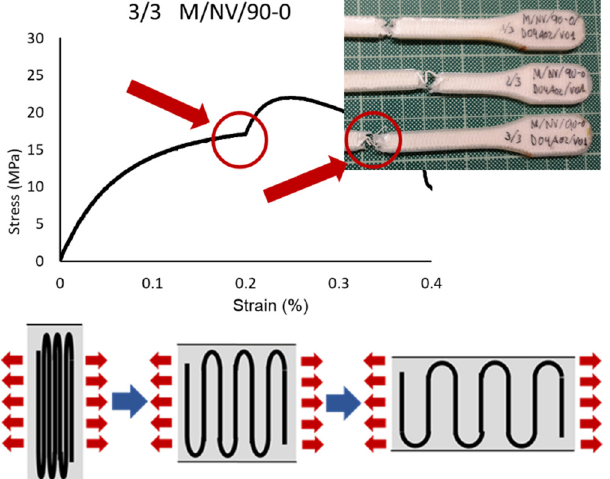
Figure 18. Break detail of 1/3 M/NV/0-0 specimen: stress-strain graph and drawing and breaking behavior scheme of the fiber.